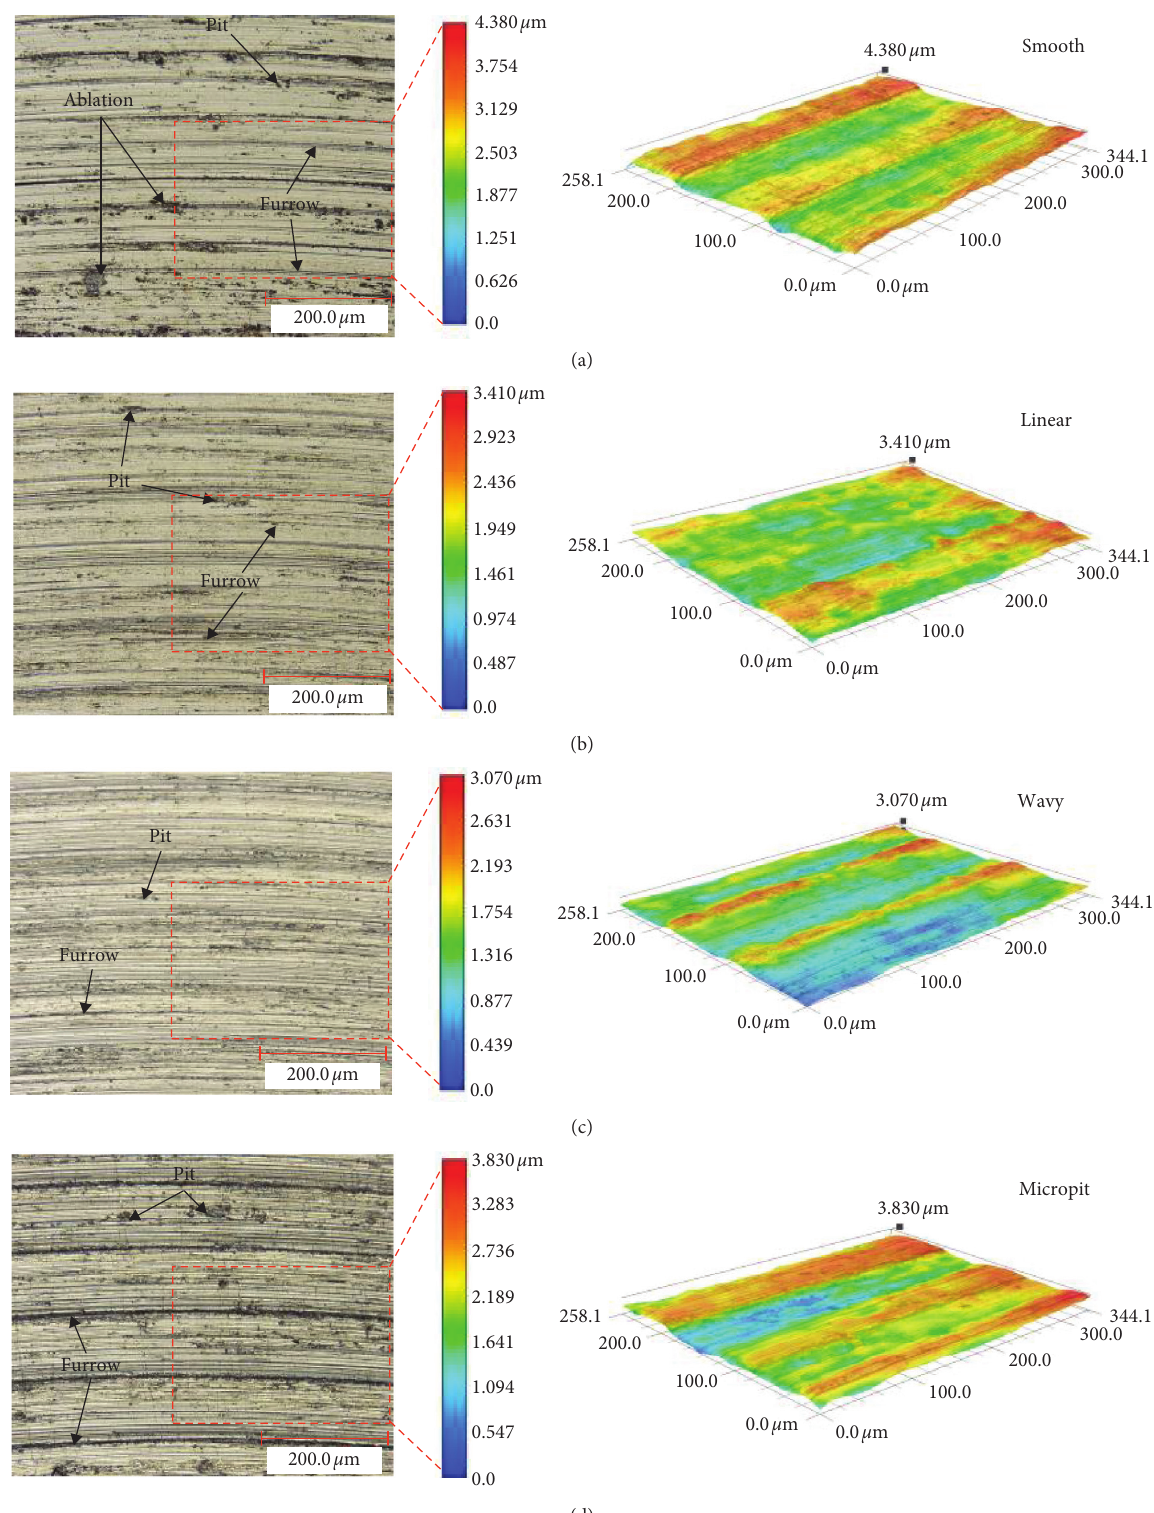
Figure 9: Photomicrographs of workpieces under different textured tool milling. (a) Nontexture, (b) linear texture, (c) wavy texture, and (d) micropit